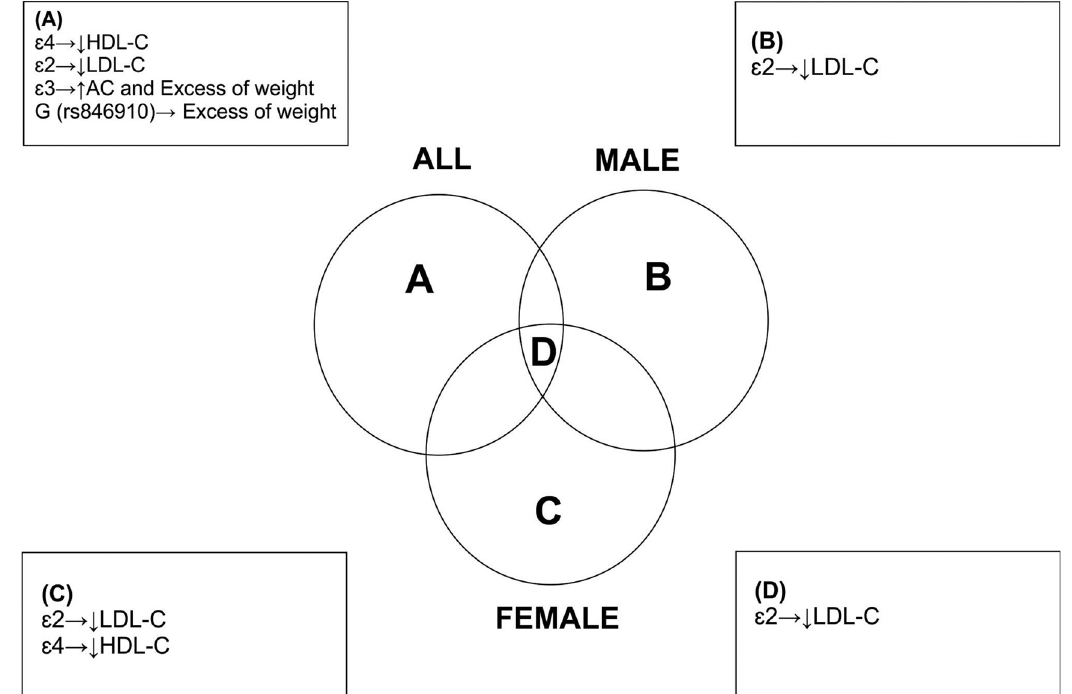
Figure 1 - Relationships between allelic variants and analyzed